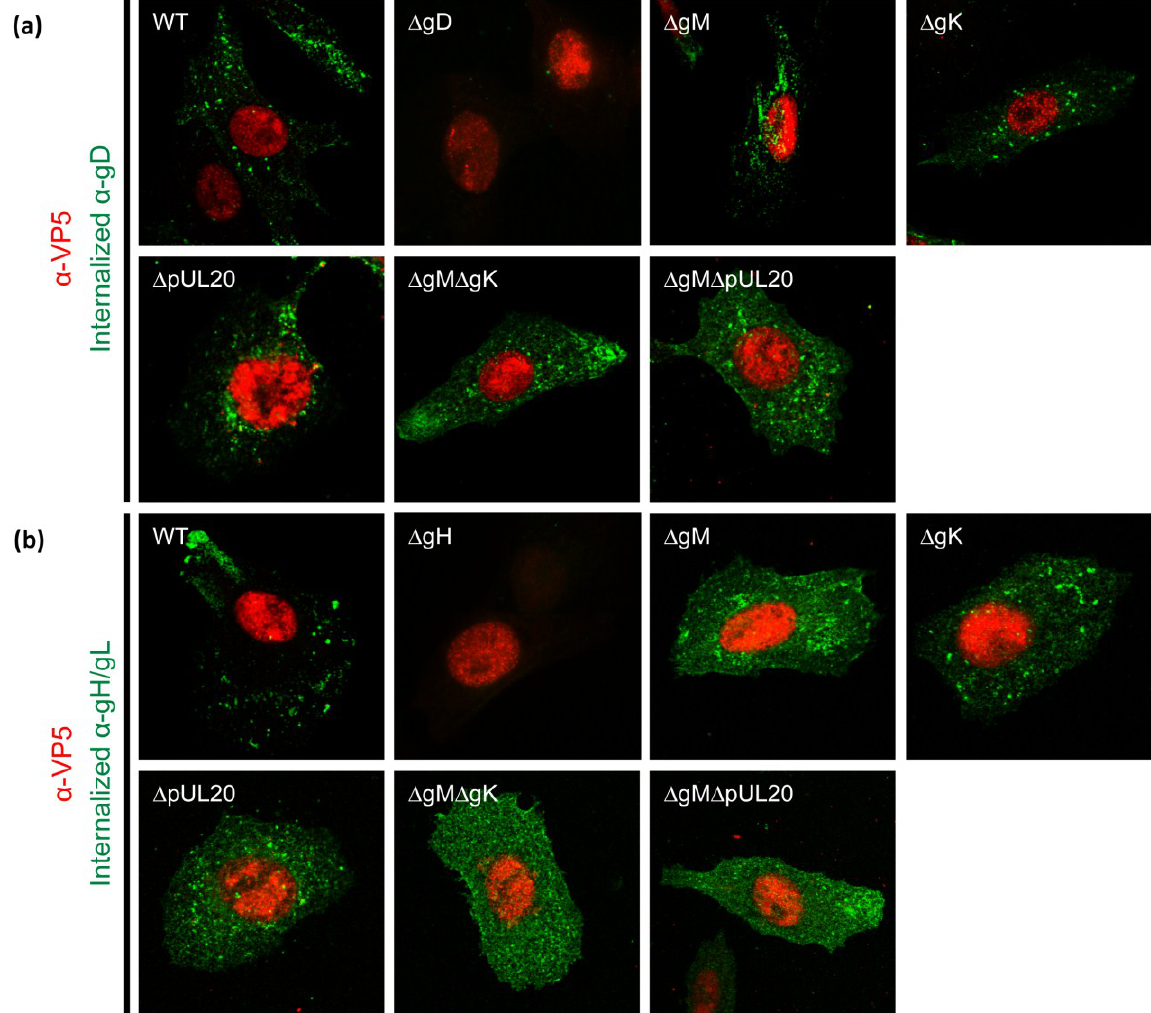
Figure 4. gD and gH/gL internalization in infected cells. Vero cells were infected with viruses as indicated at 3 PFU/cell. At 7 hpi cells were incubated with ( a ) gD or ( b ) gH/gL-specific antibodies for 1 h at 37 °C before being fixed, permeabilised and co-stained with a VP5-specific antibody as a marker for comparable